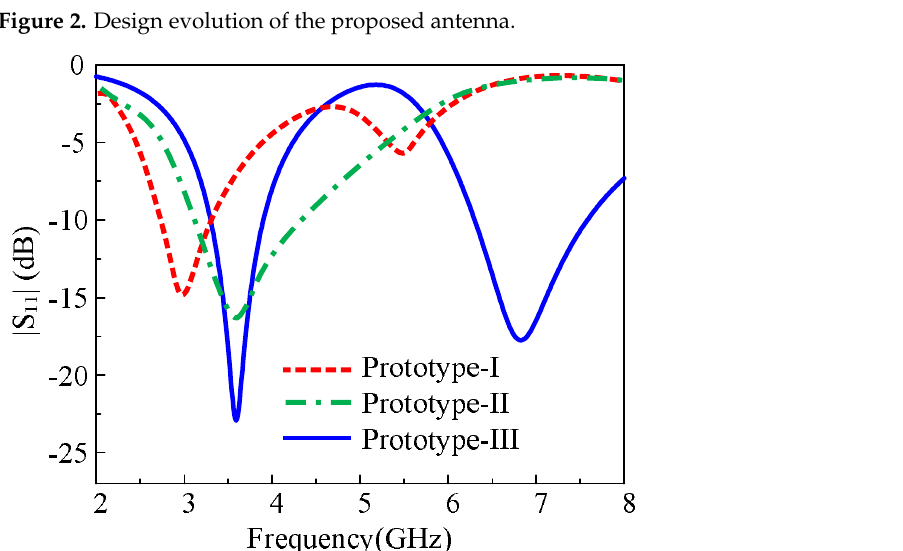
Figure 3. The simulated reflection coefficient of three different prototypes for the proposed antenna